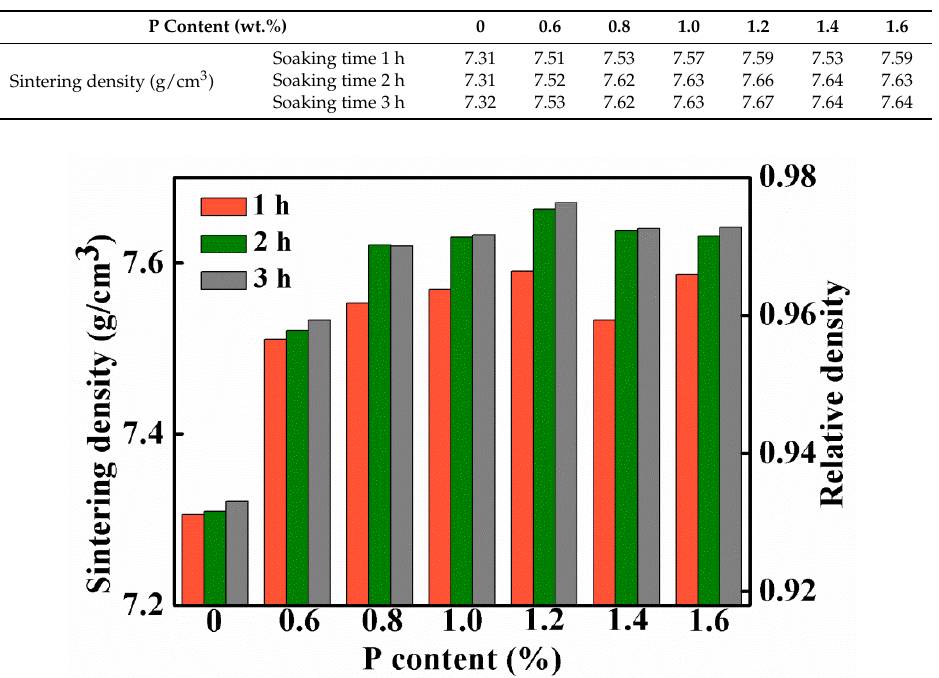
Figure 3. Sintering densities of samples with different P contents, which are sintered at 1000 °C for 1, 2, and 3 h. Table 1. A summary of green densities of Fe-x P (x = 0, 0.6, 0.8, 1.0, 1.2, 1.4, and 1.6 wt.%) samples sintered at 1000 °C for different times.